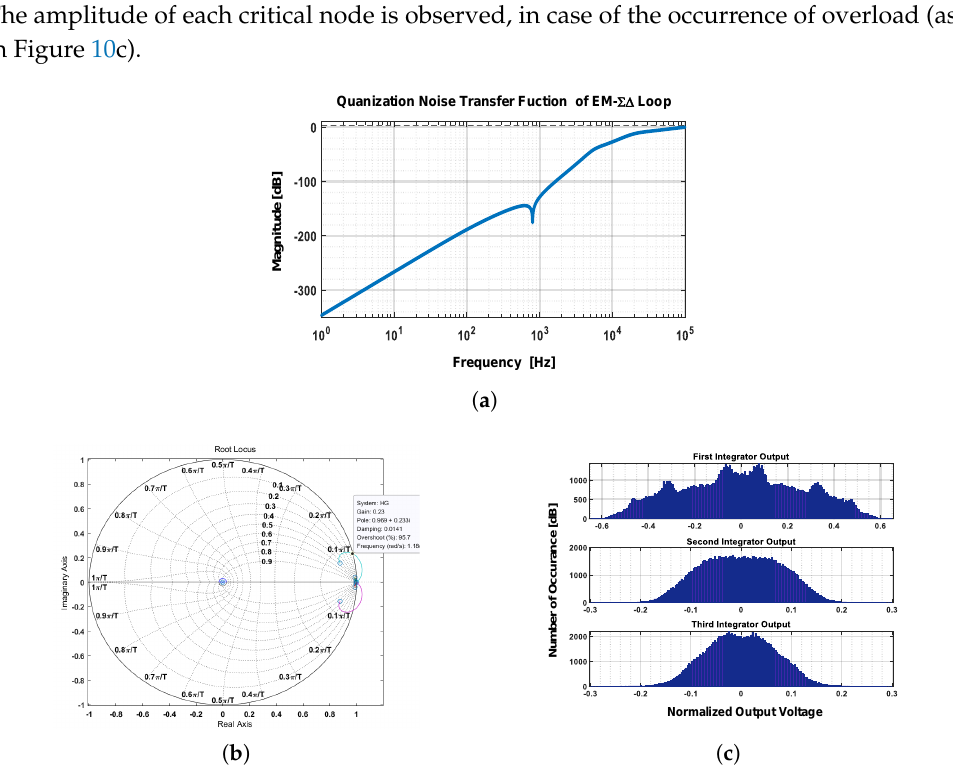
Figure 10. Test results of digital quantization noise loop: ( a ) noise transfer function (NTF) response; ( b ) root locus of the quantization noise loop; ( c ) the amplitude of each integrator